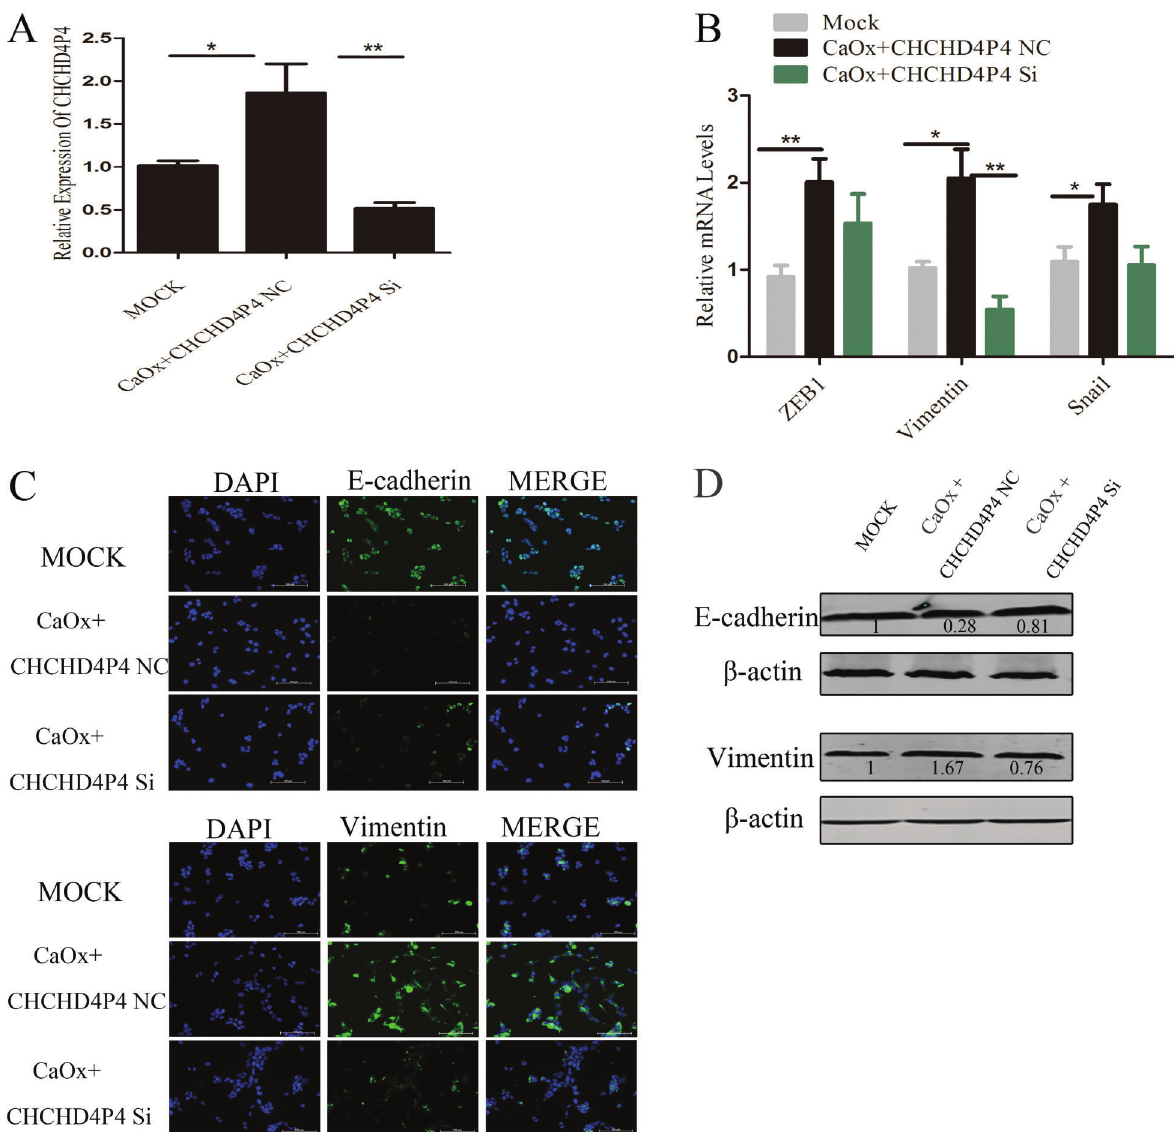
Figure 5. CHCHD4P4 silencing. HK-2 cells were transfected with the transfection agent ( A ) without siRNA (mock) or with siRNA against CHCHD4P4. mRNA levels ( B ), protein levels ( D ), and the results of the immuno fl uorescence microscopic analysis ( C ) of the EMT markers in the indicated HK-2 cells that were transfected with the siRNA against CHCHD4P4. Scale bars = 100 m m. Data are reported a means ± SD. *P o 0.05, **P o 0.01 (Student ’ s t